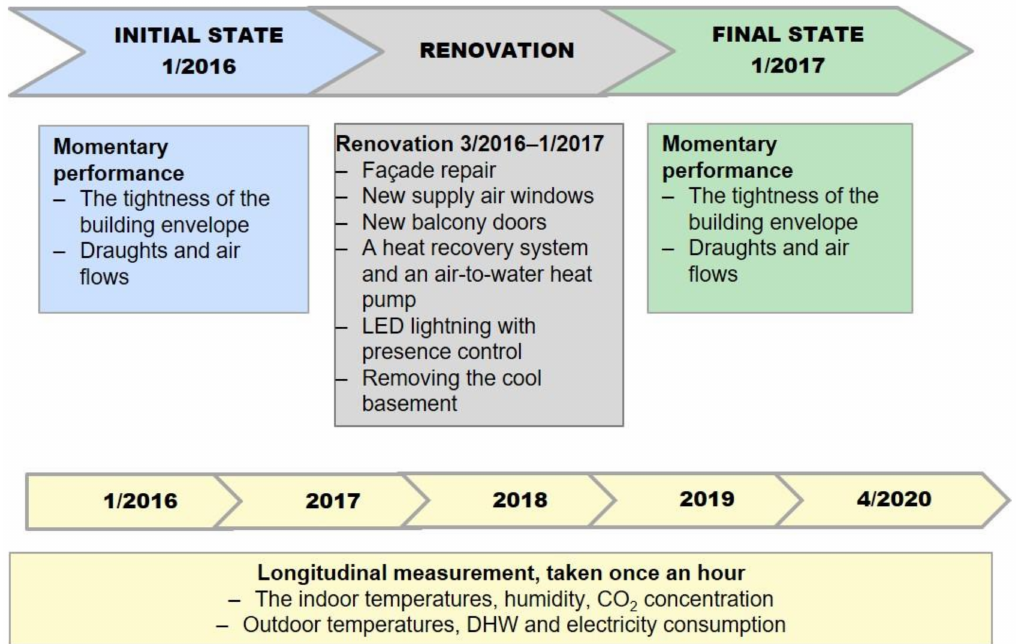
Figure 3. Renovation and performed momentary and longitudinal